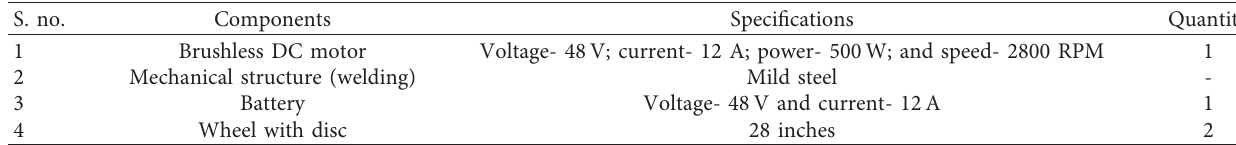
Table 2: Specifications of the proposed E-Bike.